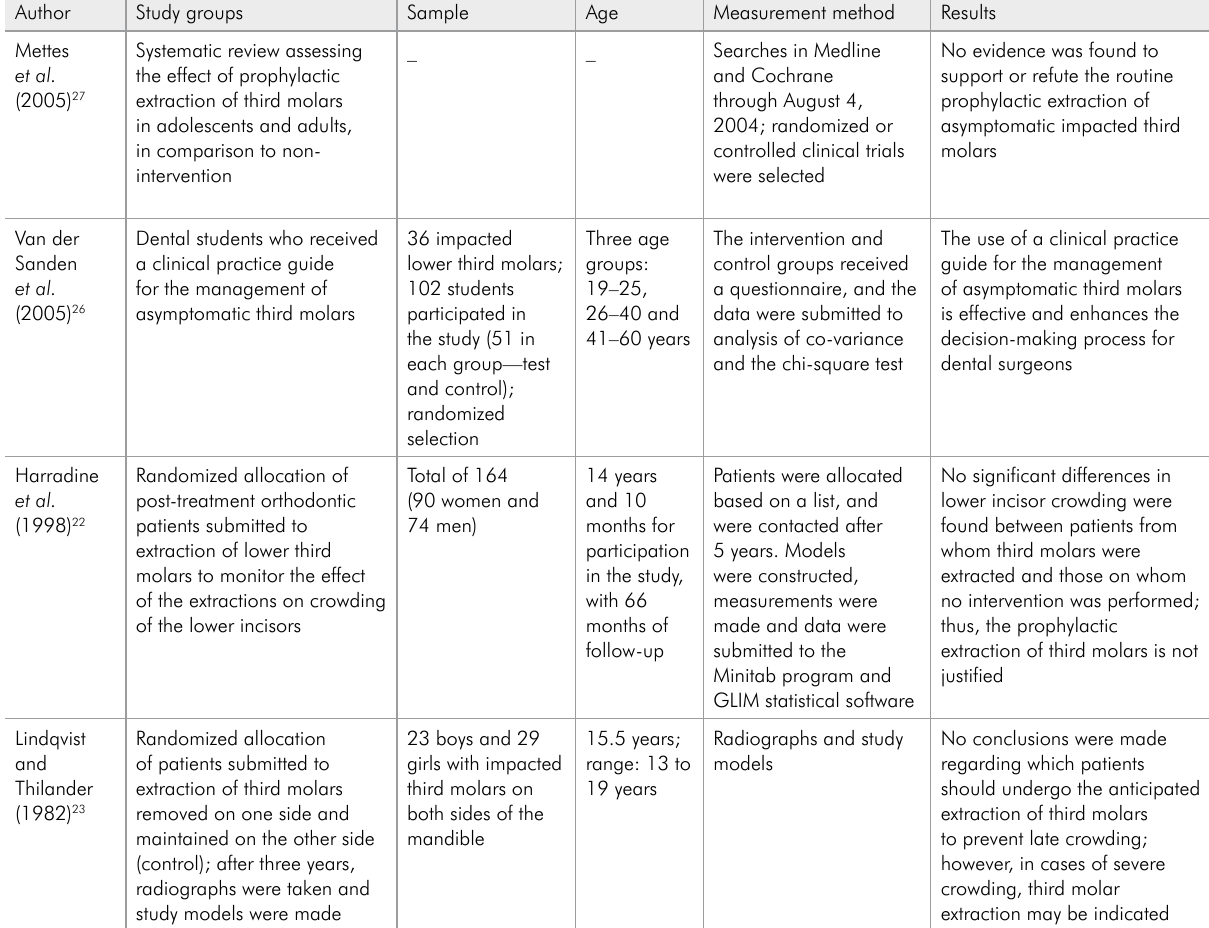
Table 3 - Studies